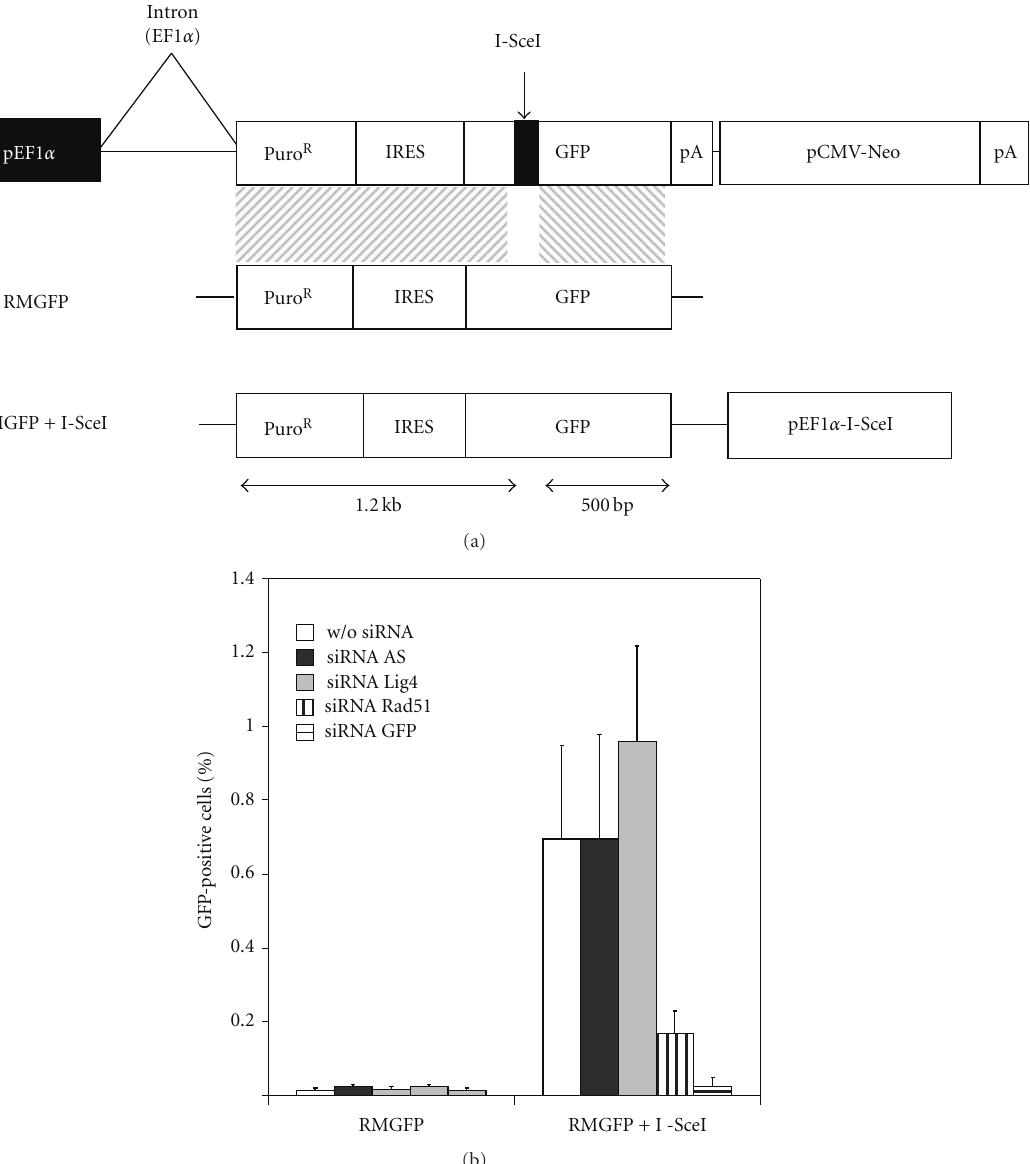
Figure 3: Cell-based assay for secondary screening. (a) Reporter system. The transgene used to assess I-SceI-induced gene targeting is integrated into the cGPS HEK-293 locus by expression of the I-CreI meganuclease. This transgene contains 1860bp of the EF1 α human promoter sequence, followed by (i) a puromycin cassette (used for selection), (ii) an IRES sequence, (iii) a GFP gene inactivated by the insertion of an I-SceI site generating a stop codon, (iv) a neomycin resistance sequence (used for selection) under the control of a CMV promoter. Repair plasmid and I-SceI induction (RMGFP+I-SceI) and repair plasmid alone(RMGFP) used for the induction of gene targeting by I-SceI are shown in the following, with the length of homologous sequence indicated. GFP reporter gene expression is assessed by flow cytometry for the quantification of gene targeting e ffi ciency. (b) A clone resistant to both puromycin and neomycin was cotransfected with RMGFP+I-SceI or RMGFP, with or without siRNA, or with the following siRNAs: AS, LIG4 , RAD51 , and GFP . GFP was detected by flow cytometry 96 hours after transfection. The results of four independent experiments are